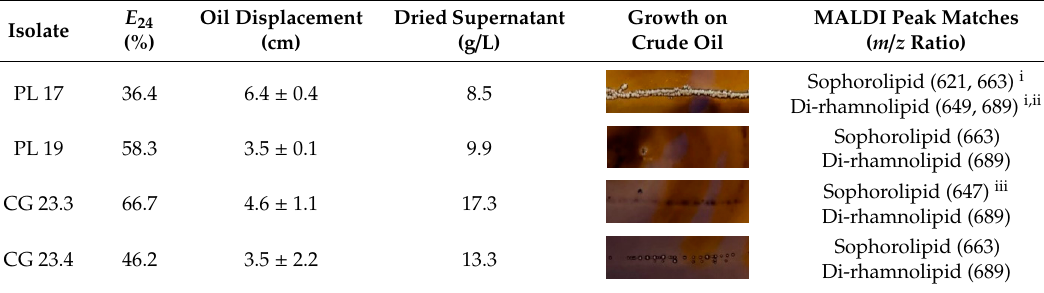
Table 2. Biosurfactant activity and putative identification.